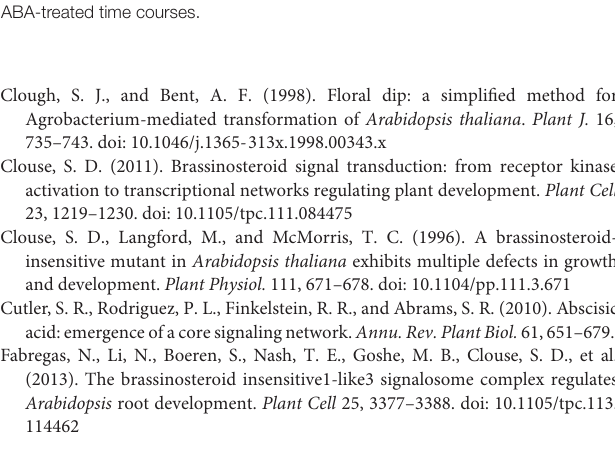
Supplementary Table 2 | DEGs are from seven GO term. Supplementary Table 3 | 12DEGs co-regulated by JMJs and BZR1. Supplementary Table 4 | 12 candidates expression change under ABA-treated time courses. Supplementary Table 5 | 18 genes expression were regulated by BZR1 and ABA/BR treatment. Supplementary Table 6 | Six candidates expression change under ABA-treated time